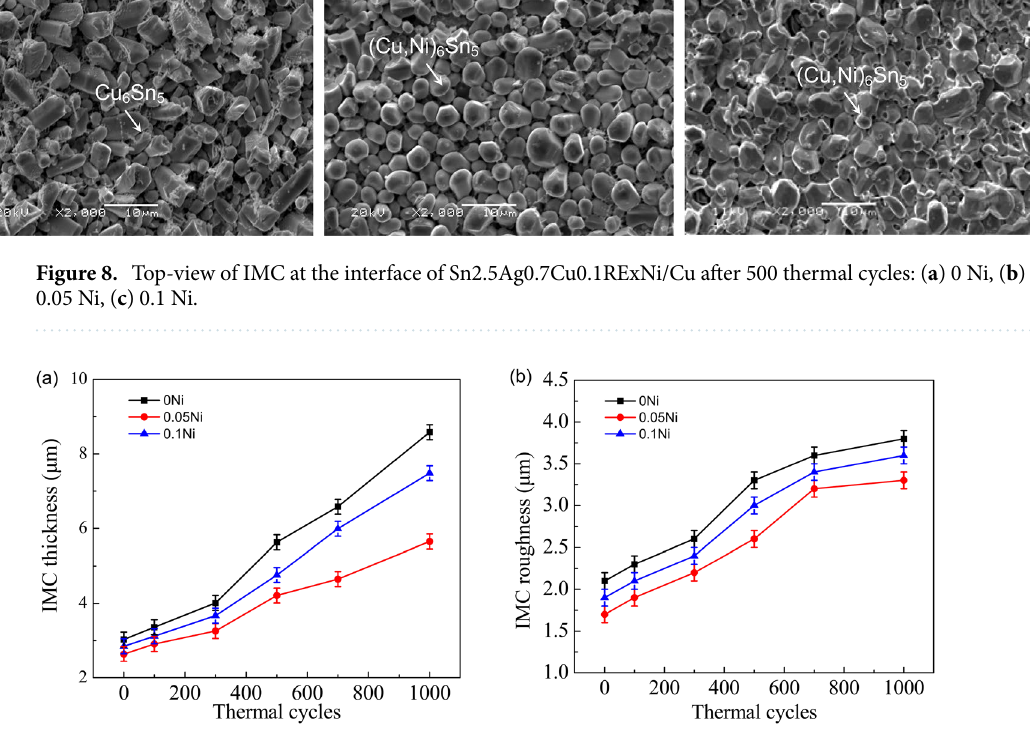
Figure 9. The interfacial IMC thickness and roughness of Sn2.5Ag0.7Cu0.1RExNi/Cu solder joints. ( a ) The interfacial IMC thickness, ( b ) the interfacial IMC